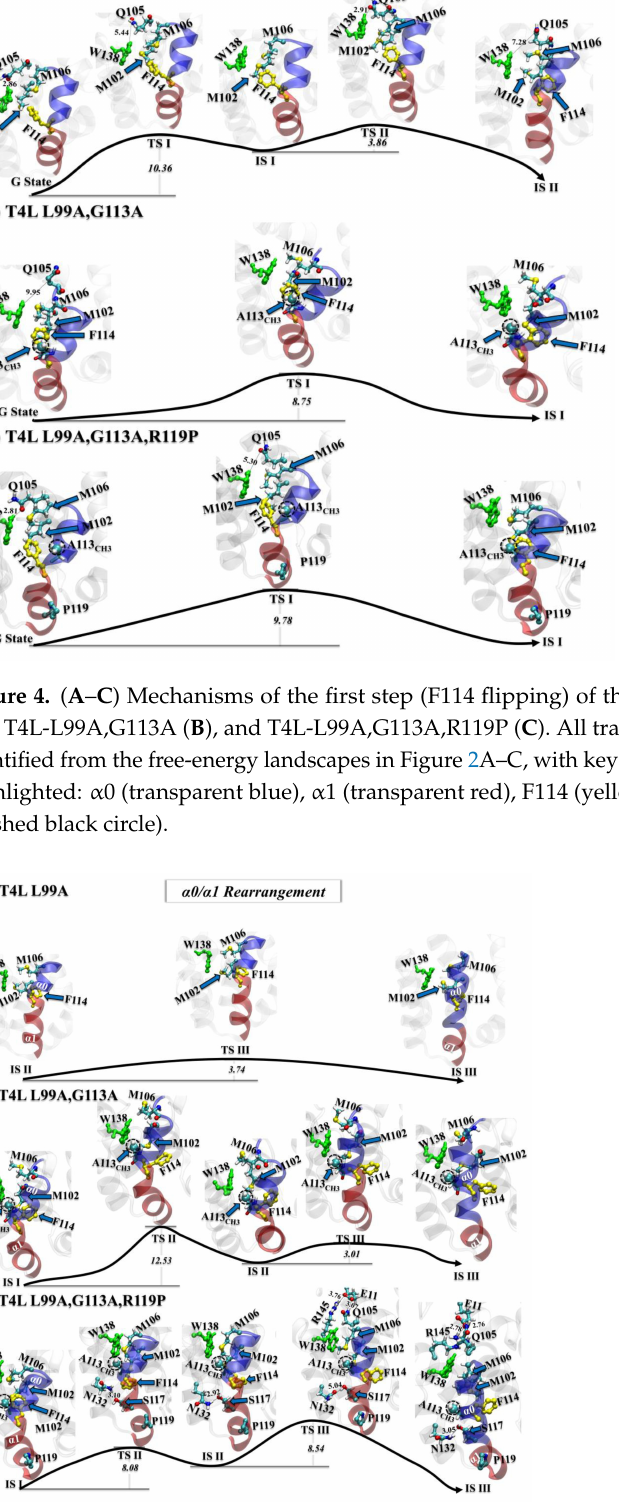
Figure 5. ( A – C ) Mechanisms of the second step ( α 0/ α 1 rearrangement) of the G → E transition for the T4L-L99A ( A ), the T4L-L99A,G113A ( B ), and the T4L-L99A,G113A,R119P ( C ). All transi- tion/intermediate states were identified from the free-energy landscapes in Figure 2A–C, with key residues and structural segments highlighted: α 0 (transparent blue), α 1 (transparent red), F114 (yellow), W138 (green), and A113 CH3 (dashed black